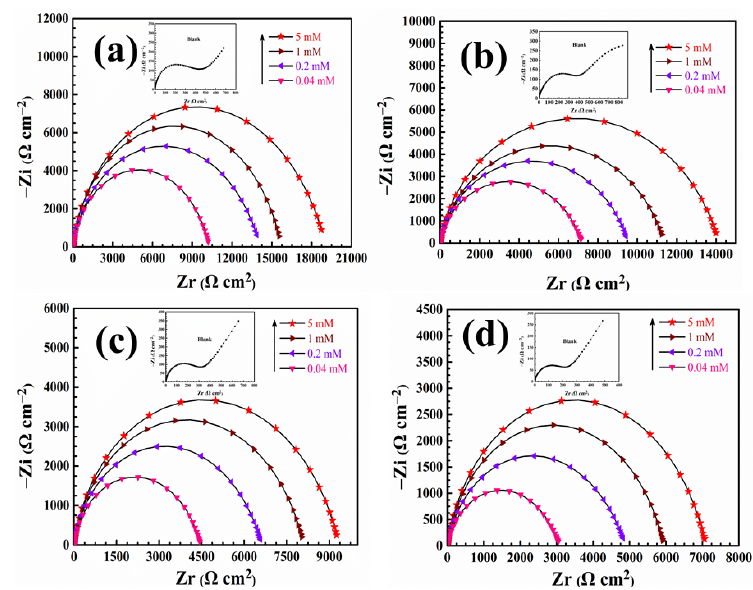
Figure 4. Nyquist plots of copper present and lacking itraconazole in 0.5 mol/L H 2 SO 4 at various temperatures: ( a ) 298 K, ( b ) 303 K, ( c ) 308 K, and ( d ) 313 K.